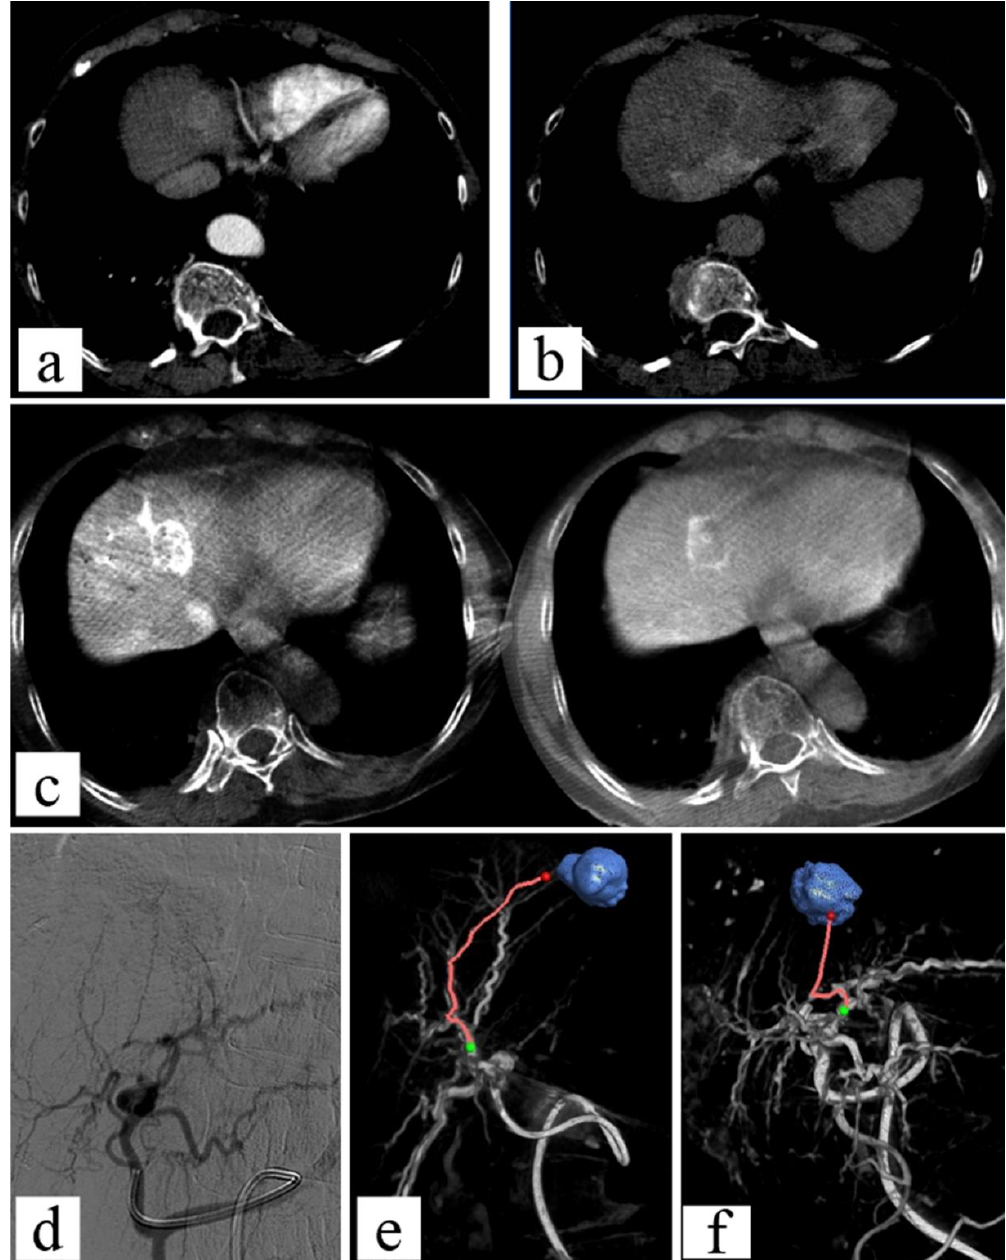
Figure 7. Seventy-year-old patient suffering from HCC: TACE. ( a , b ) Diagnostic contrast-enhanced CT in arterial and portal phase; ( c , d ) dual phase constrast-enhanced CBCT imaging shows the disisomogeneous enhancement of the lesion; ( d ) angiographic imaging does not demonstrate the lesion visualization; ( e , f ) using Emboguide software on CBCT imaging, the tumor feeders are identified.